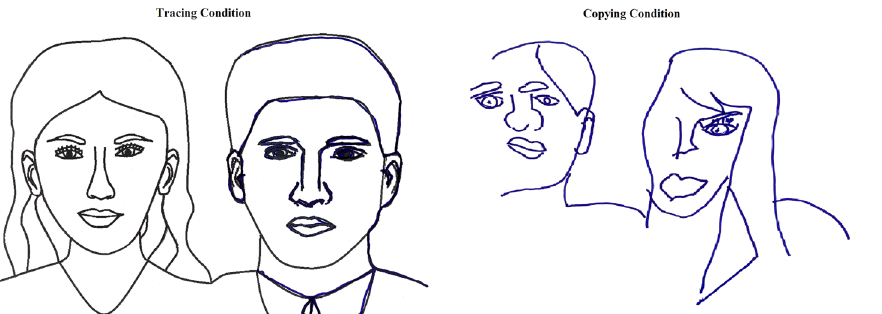
Figure 4. Example of an NP’s performance (Case 1) in the Tracing and Copying Conditions. The transparent regions on the Tracing Condition figure are those areas that the NP failed to draw over and the lines indicated in blue are those that were traced. For the Tracing Condition the NP neglected the whole left face (FL and NL regions) and parts of the left side of the right face (NR region) demonstrating egocentric neglect. Allocentric neglect was demonstrated by the same NP during the Copying Condition, where the left sides of the left (FL region) and right faces (NR region) were now